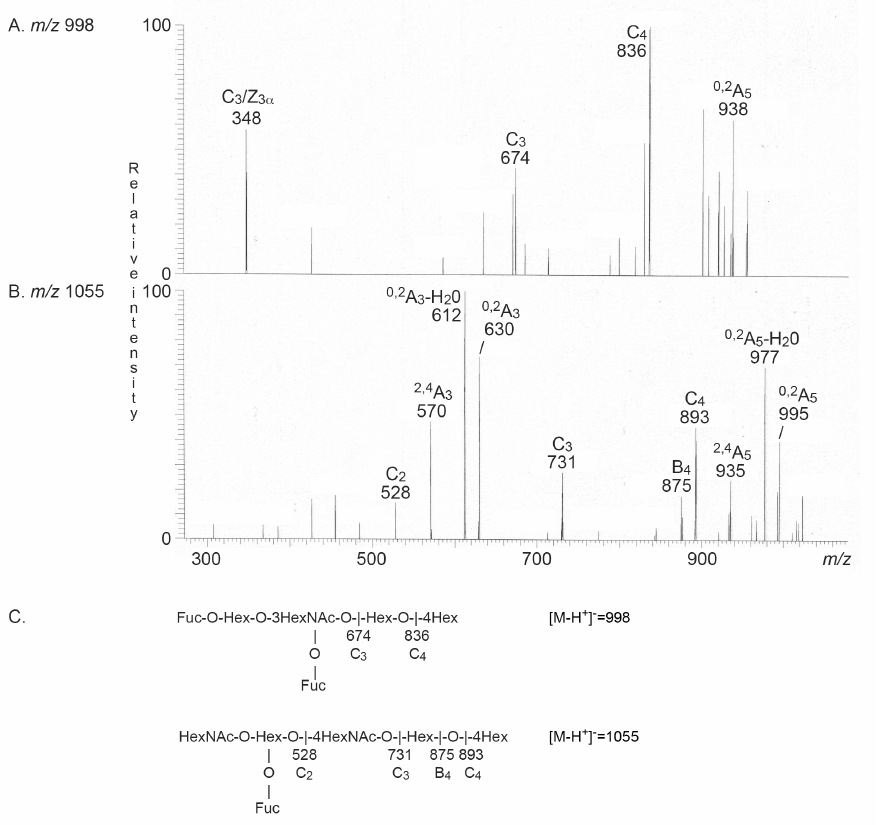
Figure 4. LC-ESI/MS of the oligosaccharides obtained from the total non-acid glycosphingolipid fraction from human thyroid gland by hydrolysis with endoglycoceramidase II from Rhodococcus spp. ( A ) MS 2 of the ion at m / z 998. The MS 2 spectrum had a prominent fragment ion at m / z 348. This ion is diagnostic for an internal 3-linked GlcNAc substituted with a Fuc at C-4 [11], and is a double glycosidic cleavage of the 3-linked branch at C 3 and Z 3 α . C-type fragment ions were present at m / z 674 (C 3 ) and m / z 836 (C 4 ), and taken together this indicated a Le b hexasaccharide (Fuc α 2Gal β 3(Fuc α 4)GlcNAc β 3Gal β 4Glc). ( B ) MS 2 of the ion at m / z 1055 gave a series of C-type fragment ions (C 2 at m / z 528, C 3 at m / z 731, and C 4 at m / z 893), demonstrating a HexNAc-(Fuc- )Hex-HexNAc-Hex-Hex sequence. A type 2 core chain was identified by the 0,2 A 3 ion at m / z 630, and the 0,2 A 3 -H 2 O ion at m / z 612. Taken together, these spectral features identified a blood group A type 2 hexasaccharide (GalNAc α 3(Fuc α 2)Gal β 4GlcNAc β 3Gal β 4Glc). ( C ) Interpretation